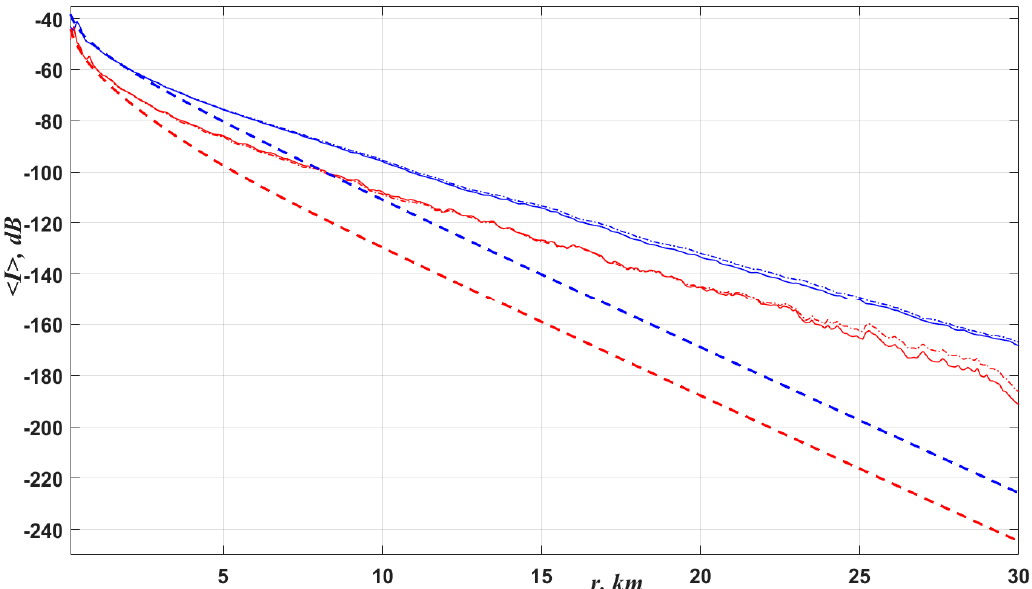
Figure 4. Similarly Figure 3 transmission loss for a waveguide with Gaussian fluctuations, L z = 20 m, L r = 4 km, and parameters of the bottom c 1 = 1200 m / s, ( ρ 1 / ρ 0 ) = 1.5, β 1 = 0.01. H - z 0 = 42 m. Blue curves: H - z = 42 m, red curves: H - z = 26 m. Thin dash curves correspond to adiabatic approximation, thick dash curves represent a deterministic waveguide ( ε = 0).